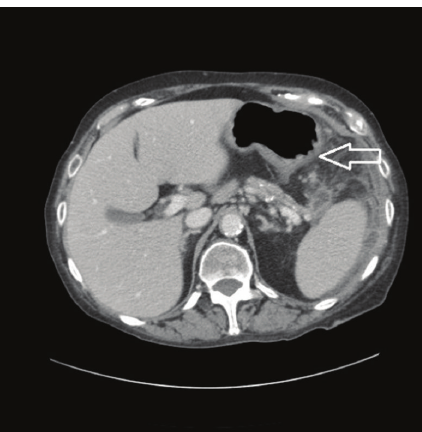
Figure 4: CT abdomen/pelvis done at admission to tertiary medical center demonstrating cut-off sign at the splenic flexure with dis- tended transverse